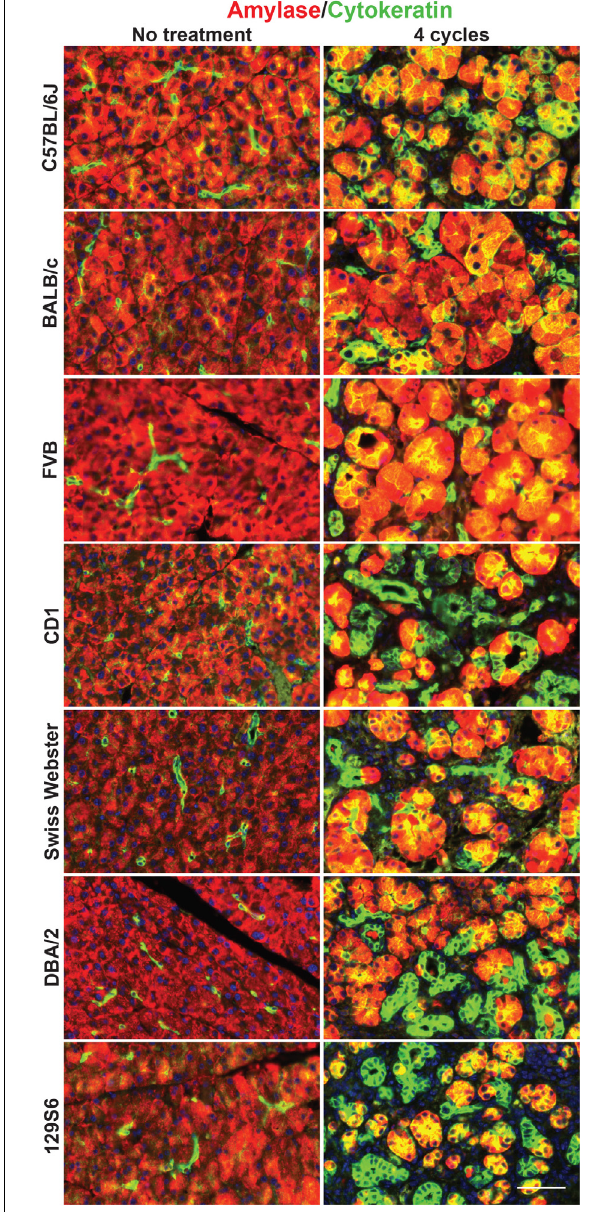
FIGURE 8 | Co-expression of acinar and ductal markers in the normal or injured pancreata of wild type mice. Immunofluorescence for acinar cell marker amylase (red) or ductal cell marker cytokeratin (green) in the pancreata of untreated or treated (four cycles of caerulein) mice from all seven strains. Cells co-positive for amylase and cytokeratin appear yellow. Scale bar, 50 µ